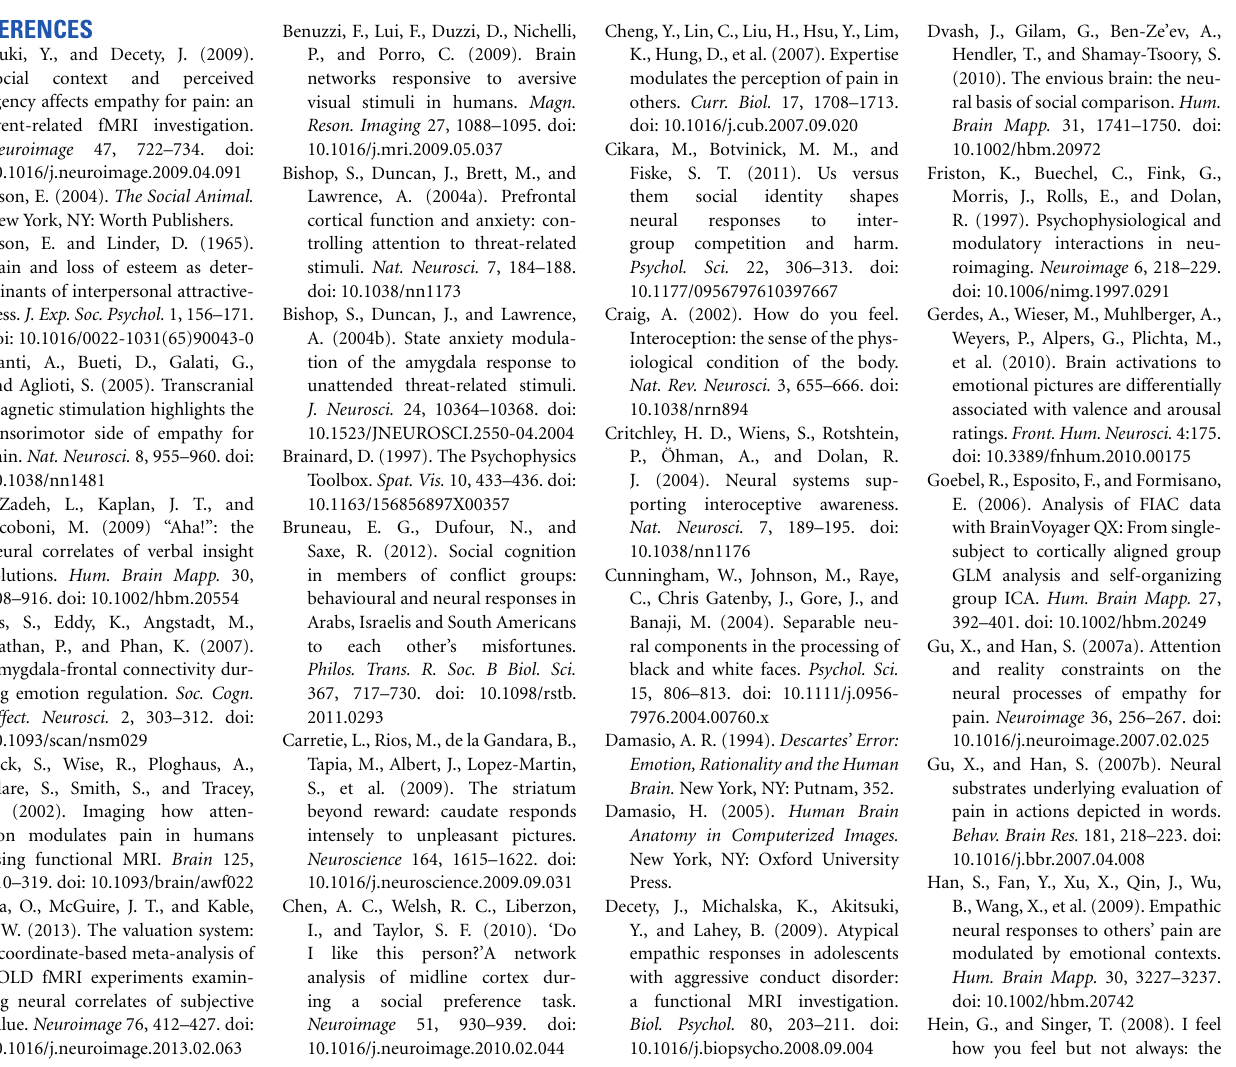
Supplementary Figure S2 | Example of hand drawn regions of interest on a single brain. Abbreviations: ACC: anterior cingulate cortex; MCC: mid cingulate cortex; AI: anterior insula; PI: posterior insula; S1: primary somatosensory; S2: secondary